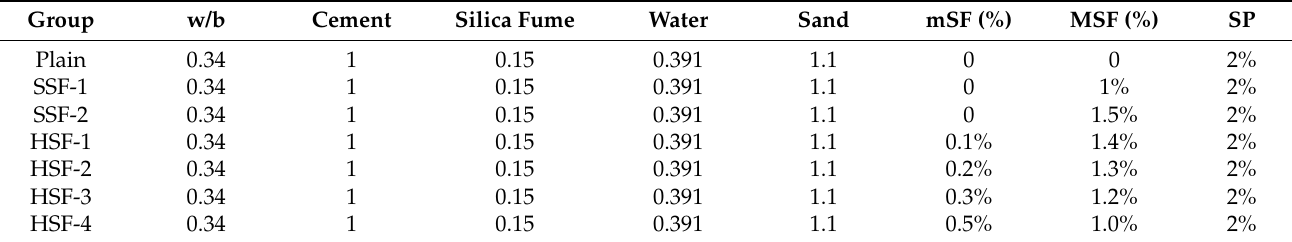
Table 2. Mix design of mixtures.